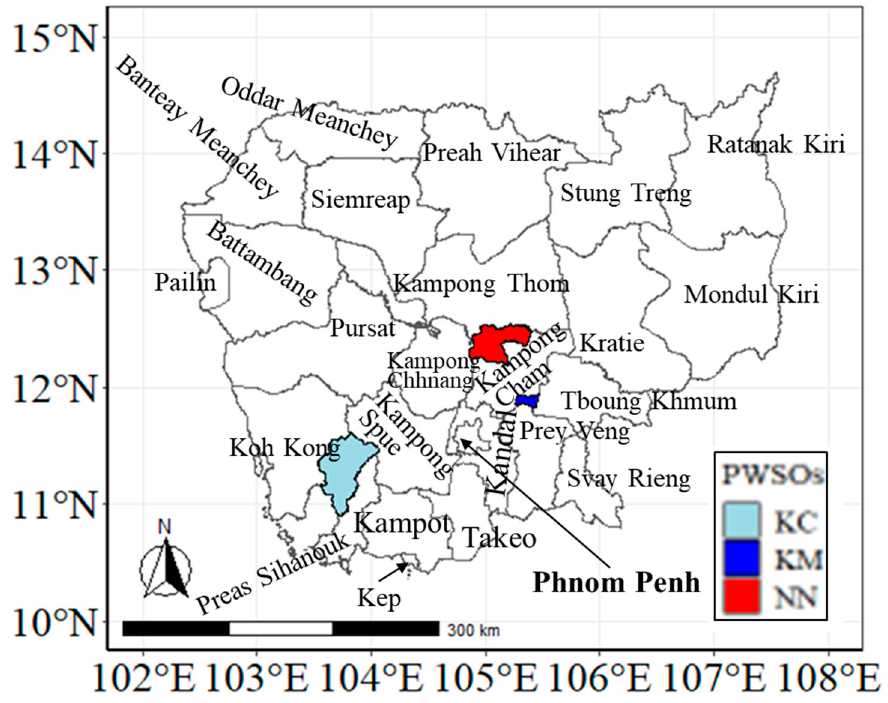
Figure 1. The locations and service areas of three PWSOs.